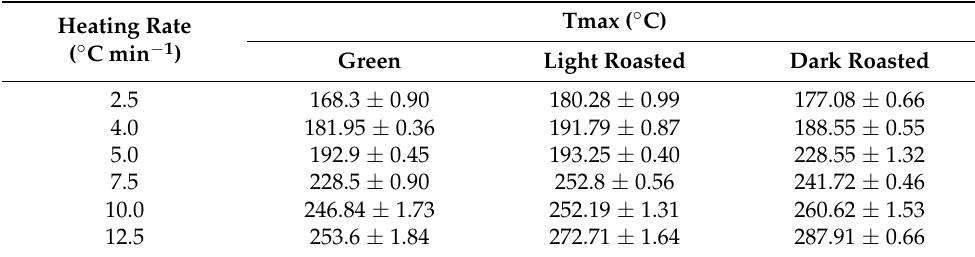
Table 3. Maximal oxidation temperatures (T max ) obtained for six sample heating rates during the thermo-oxidative processes. ( ± ) standard deviation (SD) from triplicate